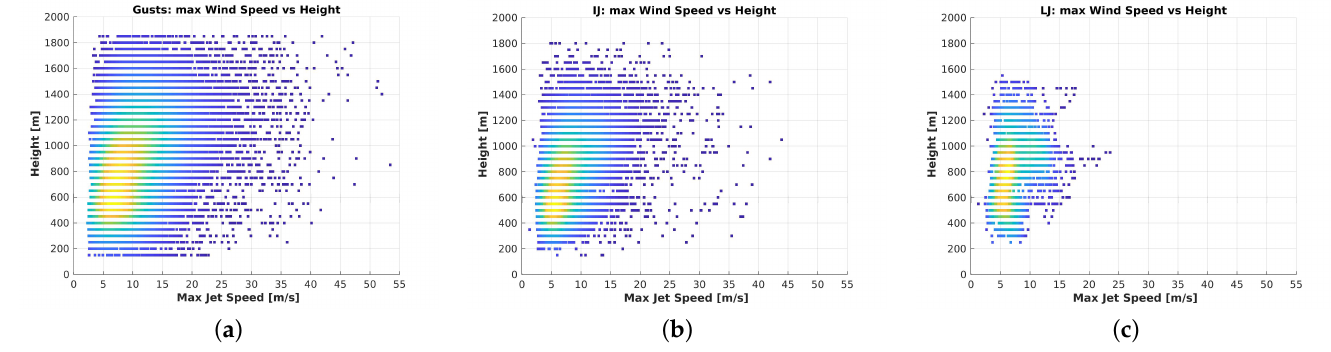
Figure 14. Dependence of the maximum wind speed in respect to the height of the different wind events. The colours blue (low) to yellow (high) in arbitrary units indicate the relative frequency of the corresponding events for 2013–2021. ( a ) Gusts, ( b ) Intermediate Jets, ( c ) Long Jets. The Mann–Whitney U test is again used to estimate if the populations of the three different wind events are statistically dependent as described already in Section 4.2. The significance level of the combination LJ and IJ is p IJ LJ (cid:28) 0.01 with Pearson correlation − = coefficient r IJ 2.5 10 − 3 , the combination gusts and LJ gives p G LJ LJ (cid:28) 0.01 and − · − −